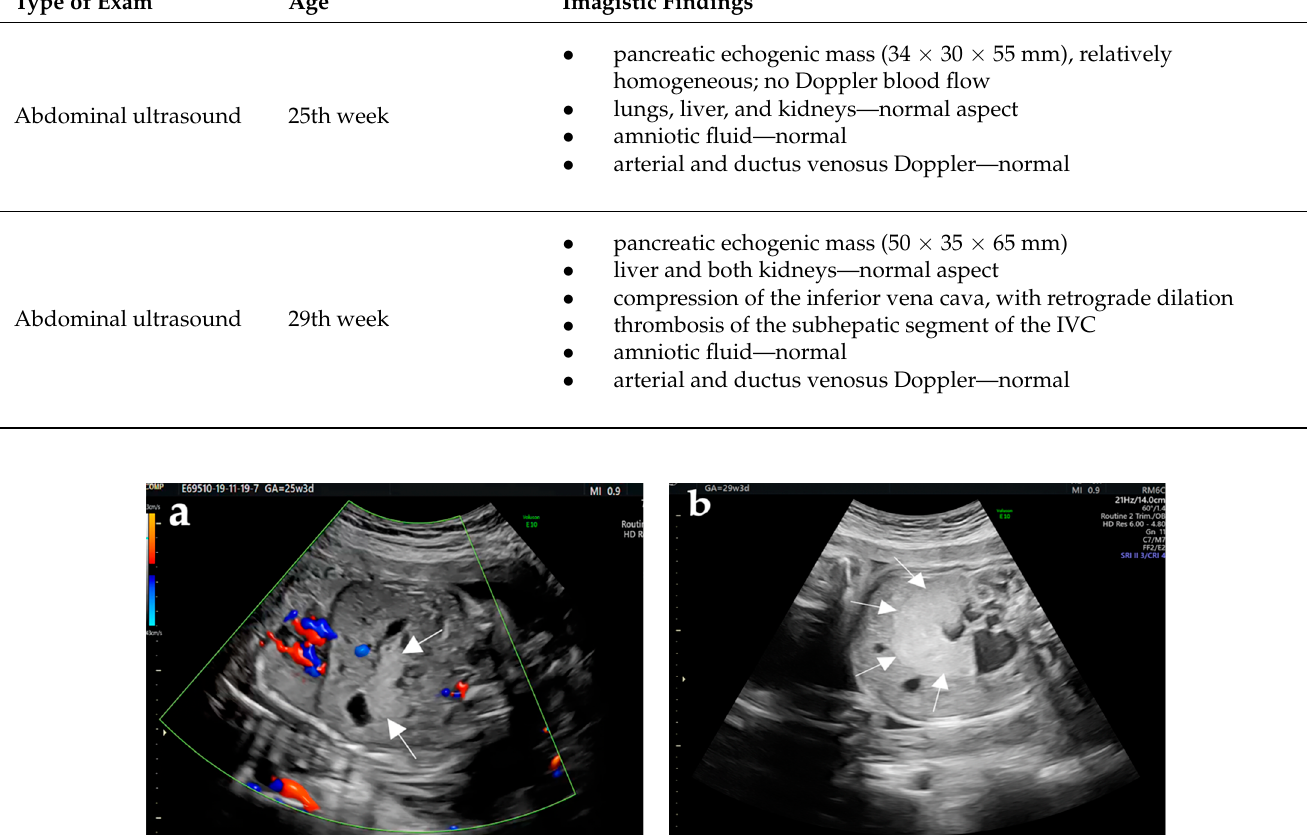
Table 1. Synopsis of prenatal imagistic findings.